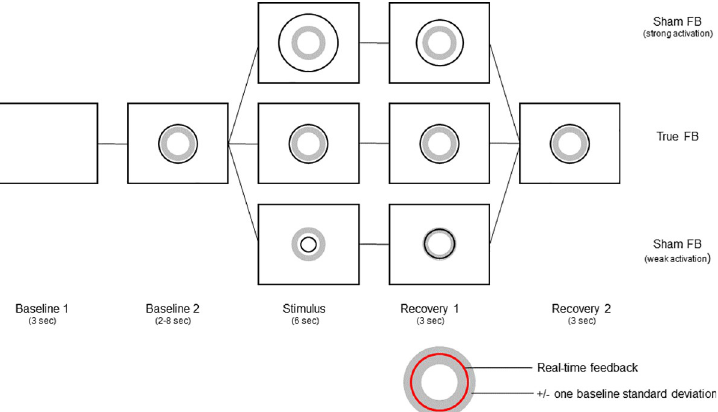
Fig 1. Experimental procedure. Sequences during true pupillary feedback (central row) and sham feedback trials (weak: Lower row; strong: Upper row). The dark circle (coloured red in the original display) depicts pupil size changes in real-time; the grey circle indicates one standard deviation of the average pupil diameter during baseline